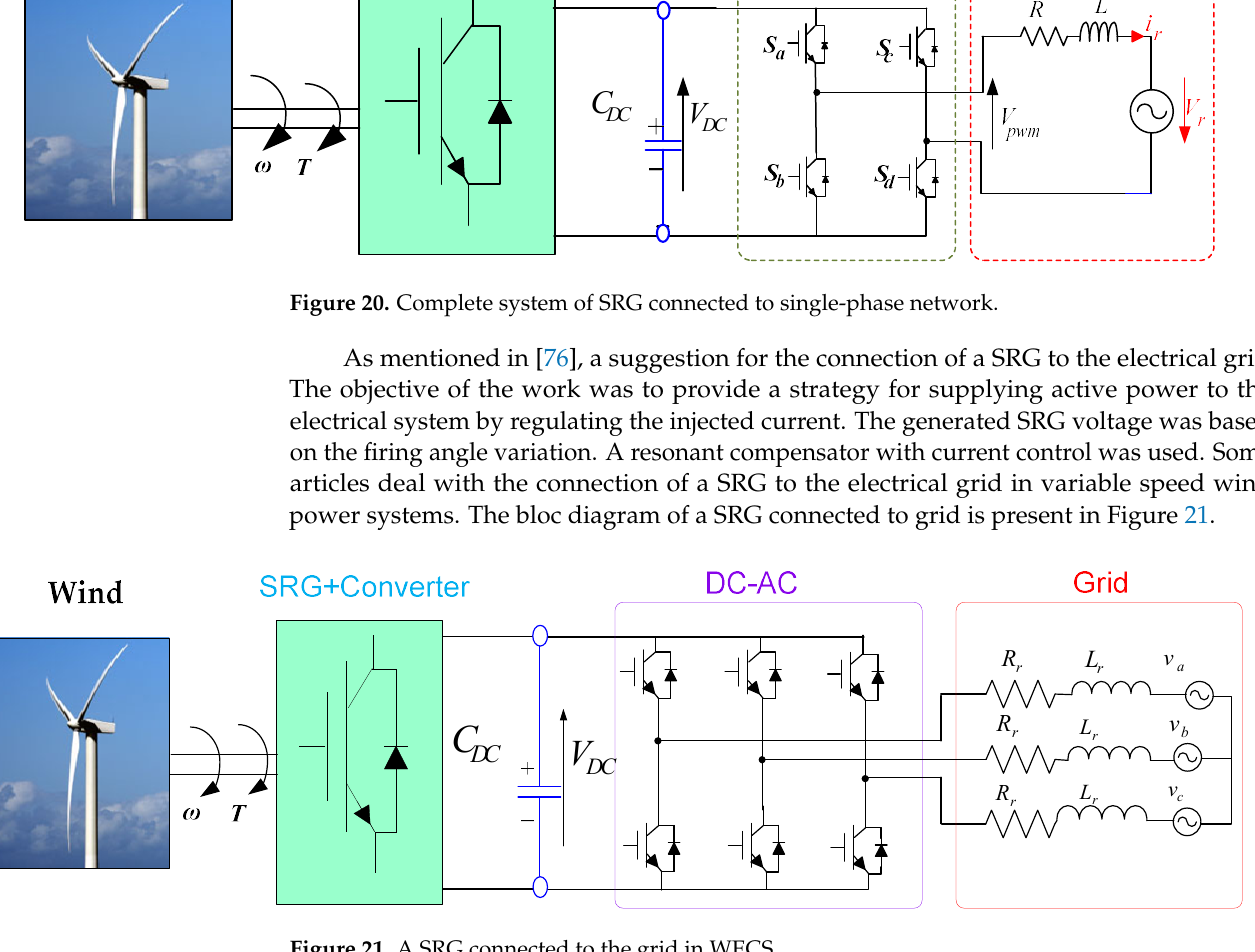
Figure 21. A SRG connected to the grid in WECS.